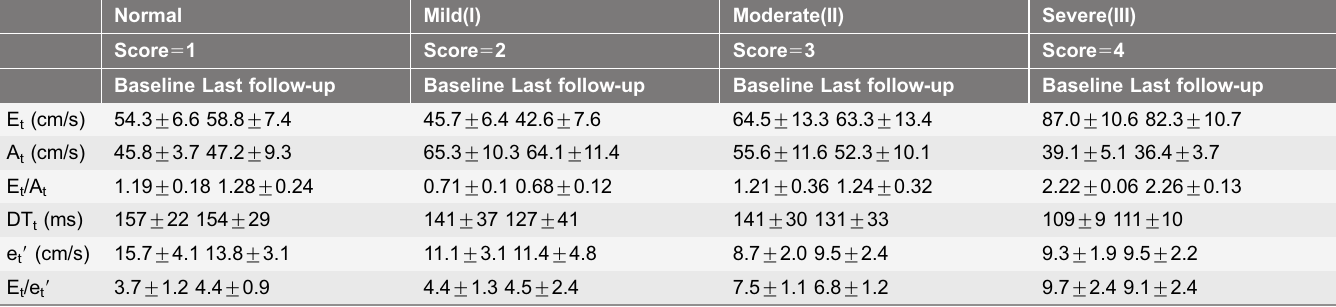
Table 4. Right ventricular diastolic dysfunction (RVDD) at baseline and the last follow-up.